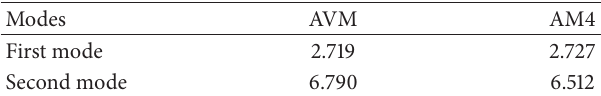
Table 8: Experimentally and mathematically identified modal frequencies